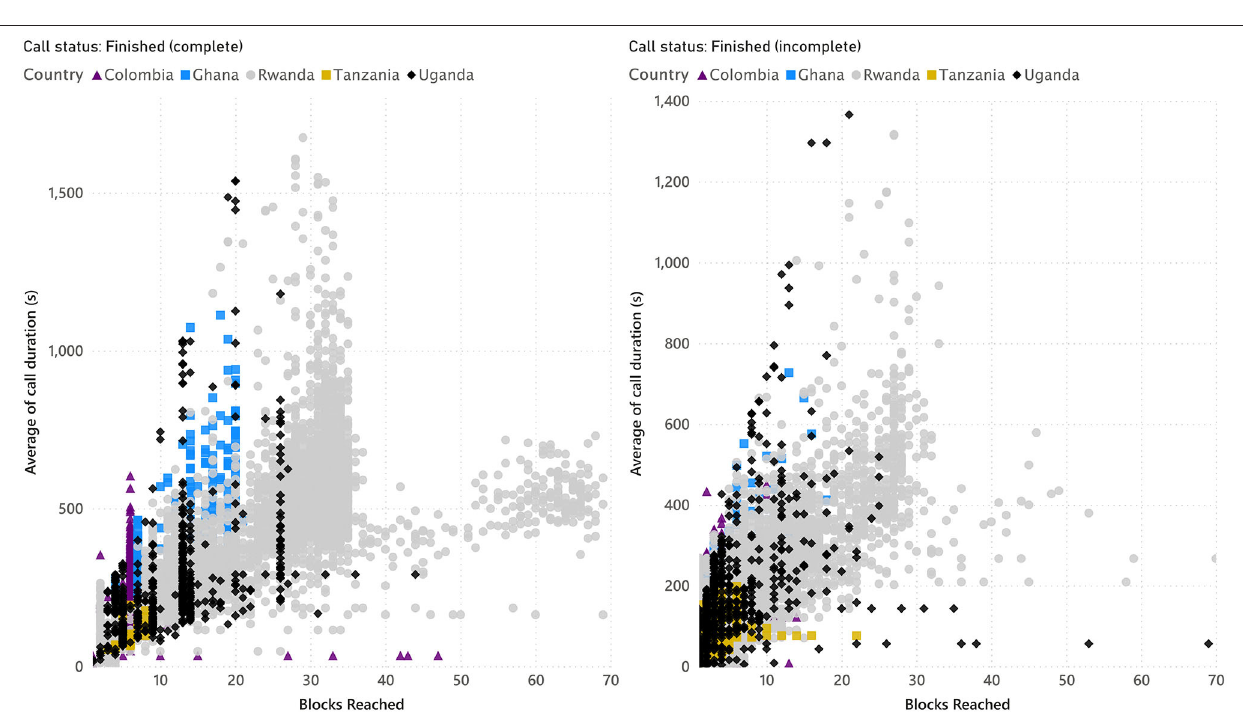
Frontiers in Sustainable Food Systems |